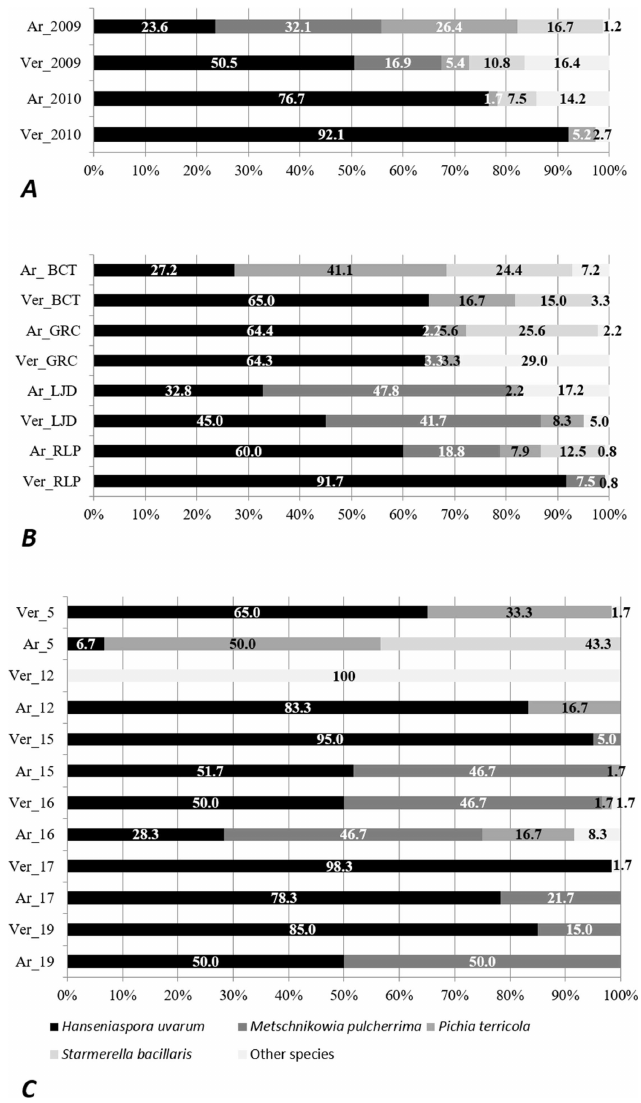
Fig 3. Yeast communitiescomposition (in percentage)from freshly crushedgrapes of the grapevinecultivars Verdelhodos Ac¸ores (Ver) and Arinto da Terceira (Ar) collectedin 2009 and 2010 on A) all sampledlocations, B) in Lajidos(PLJ), the remaininglocationsof Pico (PRL), in Biscoitos(BCT) and in Graciosa (GRC) and C) in six vineyard (numbers 5, 12, 15, 16, 17 and 19; see Table